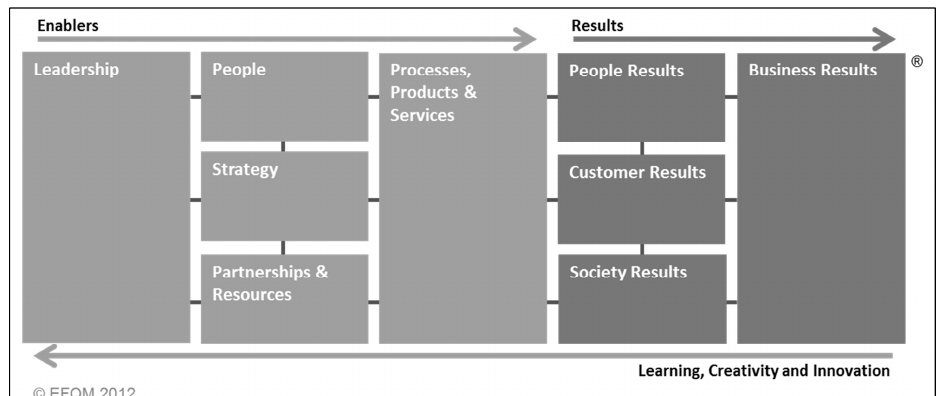
Figure 3 bellow presents the actual Model Criteria of the 2013 version (source: an Overview of the EFQM Model,